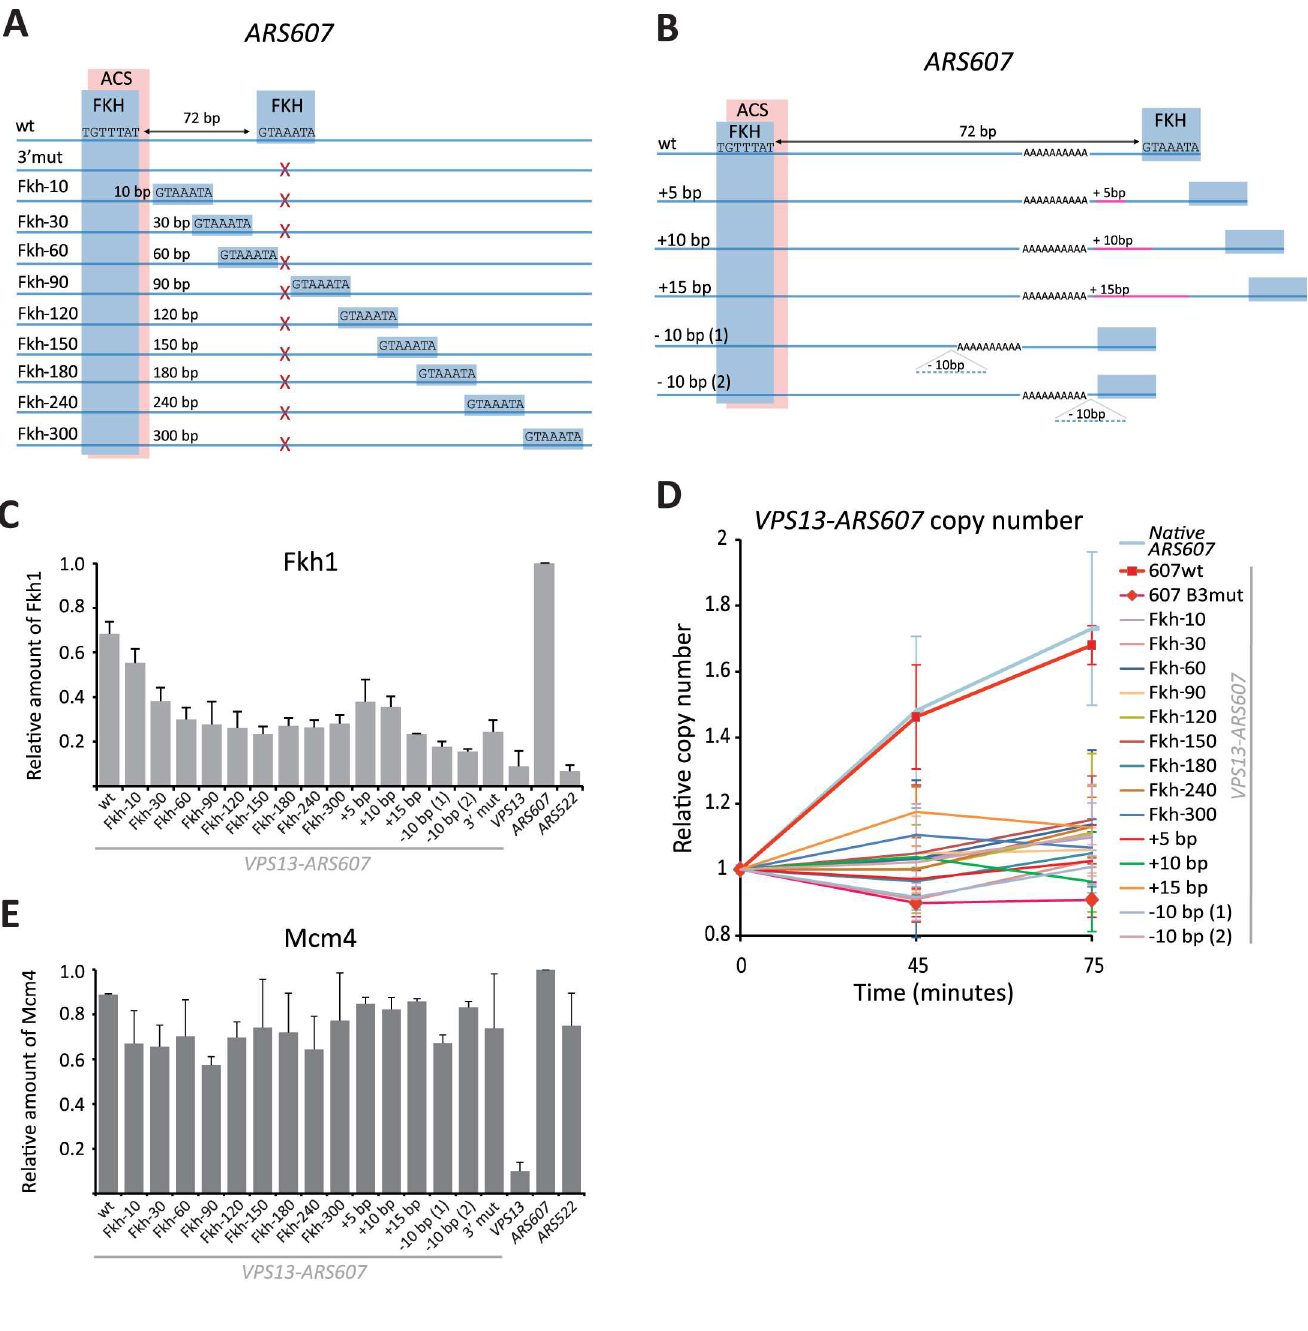
Fig 1. Alterations of distance between the Fkh1/2 binding sites in ARS607 .(A) Schematic representation of ARS607 origins insertedinto the GAL - VPS13 locus. Approximatelocationsof Fkh1/2 consensus bindingsites (blue boxes) and the ACS (pink box) are indicated. In all constructs except wt ARS607 the ACS-distal (3’) Fkh1/2 bindingsite was mutated (red X) and a new Fkh1/2 site was introducedat variousdistances from the ACS-proximal (5’) site. (B) Depictionof modified ARS607 origins with small insertions and deletionsbetweenFkh1/2 binding sites. Approximate locationsof Fkh1/2 consensusbindingsites (blue boxes), the ACS (pink box), poly-A track and sites of nucleotide insertions or deletions are indicated.Detailedsequences of all modifiedorigin loci are shownin S4 Fig. (C) Fkh1 bindingto ARS607 with altered distances betweenFkh1/2 sites as determined by ChIP assay. Fkh1 occupancyat mutant ARS607 is shown relative to its bindingto the native ARS607 locus in the same strain. A strain with no ARS in the VPS13 locus and the native late-replicating origin ARS522 that containsno Fkh1/2 bindingsites are shown as controls ( VPS13 and ARS522 , respectively). (D) Relativecopy number of VPS13 - ARS607 DNA in HU-arrestedcells. Cells were arrested in G1 with α -factor and then releasedinto HU-containing media for 45 and 75 minutes. Graphs show the ratio of VPS13 - ARS607 and late-replicating ARS522 loci, the ratio in G1-arrested cells was set as 1. Relative